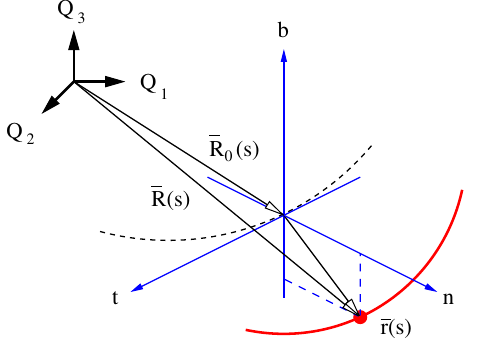
FIG. 6. Illustration of a test particle ’ s position vector expressed as a transverse, i.e. for fixed q 3 , displacement from equilibrium